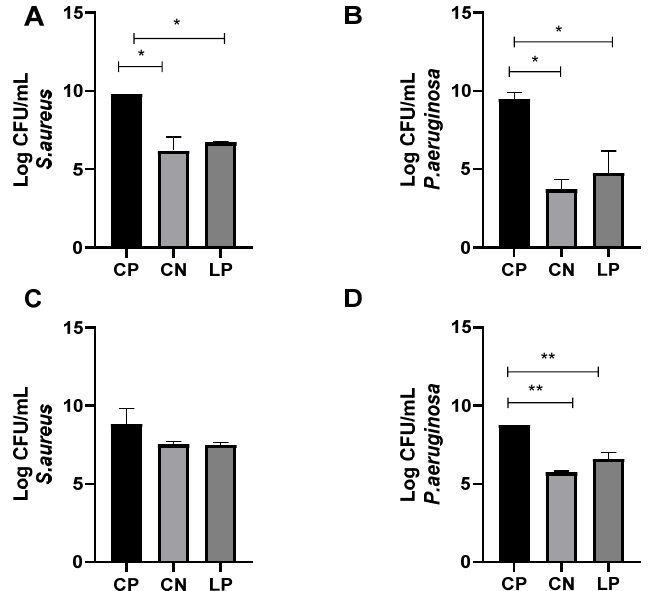
Figure 3. Evaluation of antimicrobial effects of L. plantarum LP-G18-A11-incorporated gel (5%) in an ex vivo model of skin wound. * p < 0.05; ** p < 0.01. CP: ( A , B ): Antimicrobial effects after 24 h. ( C , D ): Antimicrobial effects after 72 h. Positive control ( Staphylococcus aureus or Pseudomonas aeruginosa) ; CN: Ciprofloxacin; LP: Lactiplantibacillus plantarum LP-G18-A11. Table 3. Organoleptic and physical-chemical characteristics of gel containing L. plantarum LP-G18-A11 in preliminary stability